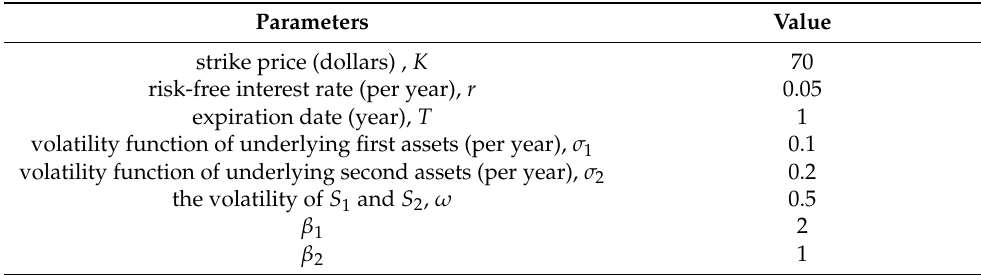
Table 1. Parameters of the numerical solutions. Parameters Value strike price (dollars) , K 70 risk-free interest rate (per year), r 0.05 expiration date (year), T 1 volatility function of underlying first assets (per year), σ 1 0.1 volatility function of underlying second assets (per year), σ 2 0.2 the volatility of S 1 and S 2 , ω 0.5 β 1 2 β